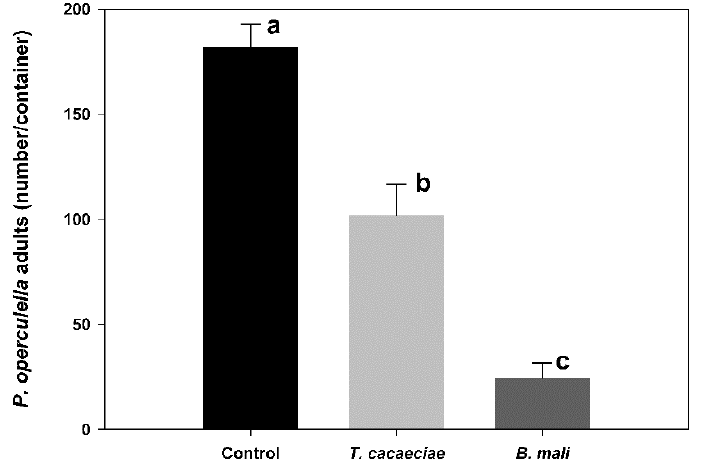
Figure 1. Mean number of P. operculella adults (PTM) ( ± SE) after 49 days when an initial release of B. mali or T. cacaeciae was carried out, compared to the control, under storage conditions (values with different letters indicate significant differences at p = 0.01).